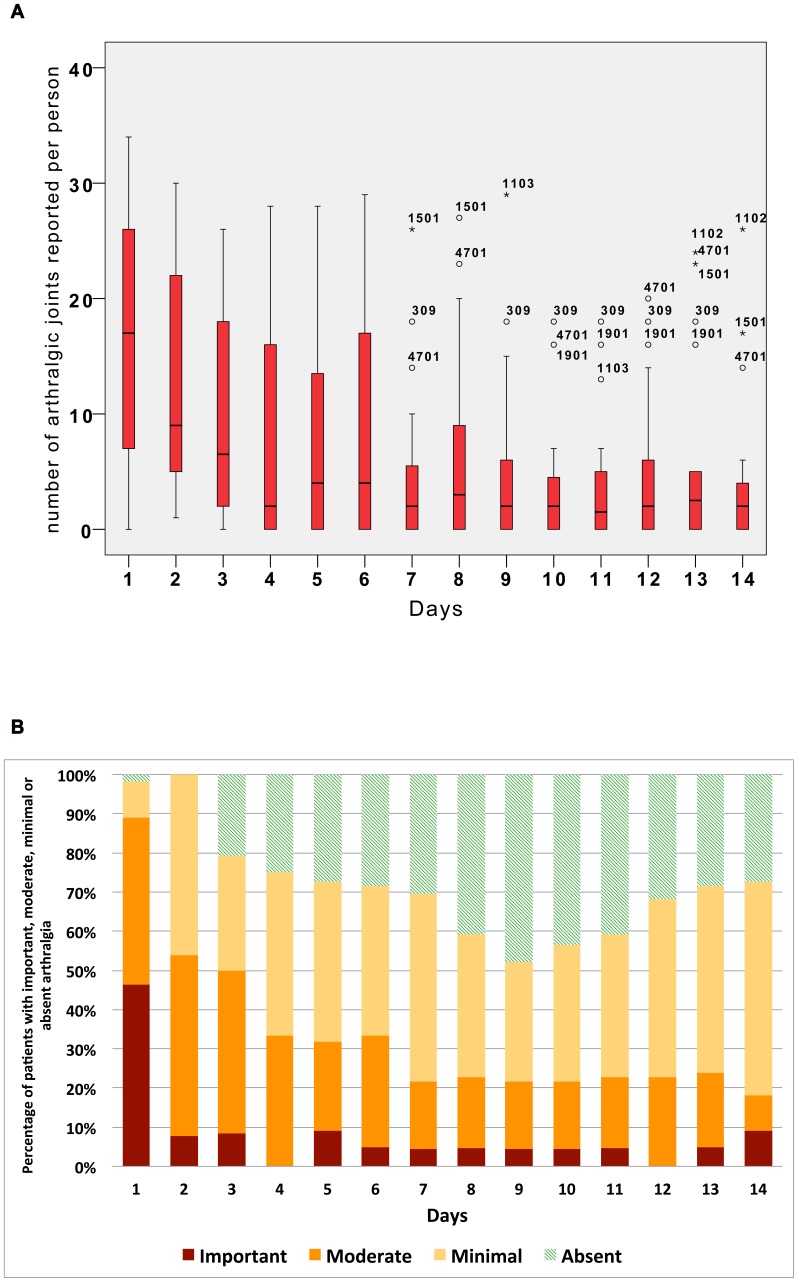
Number and intensity of arthralgic joints for CHIKV+ve* patients.
Figure 3A: Self reported number of arthralgic joints reported per person (day 1–day 14). Figure 3B: Percentage of patients with absent, minimal, moderate or severe arthralgia (day 1–day 14). * Characteristics of patients included and details of box plots are the same as reported in

figure 2

.